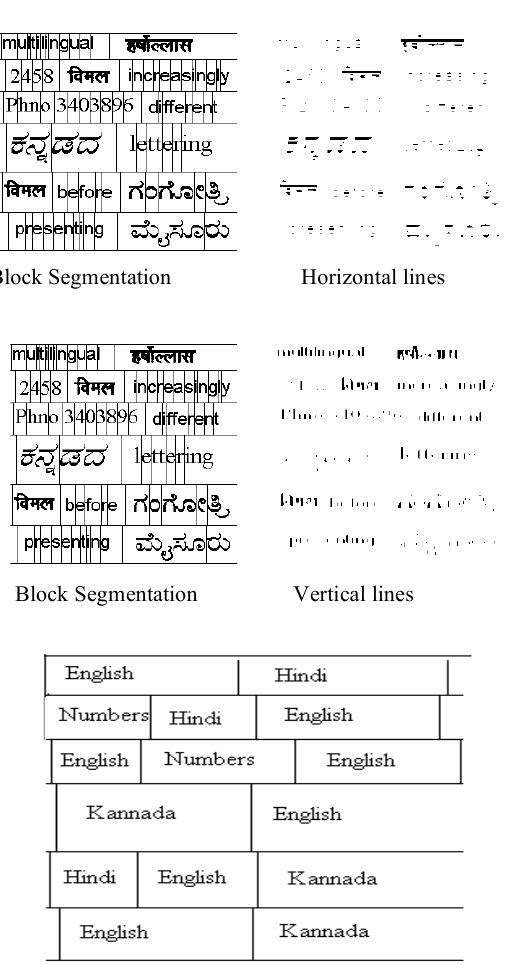
Figure 8. Sample output images of English, Hindi, Kannada text words and Hindu Arabic